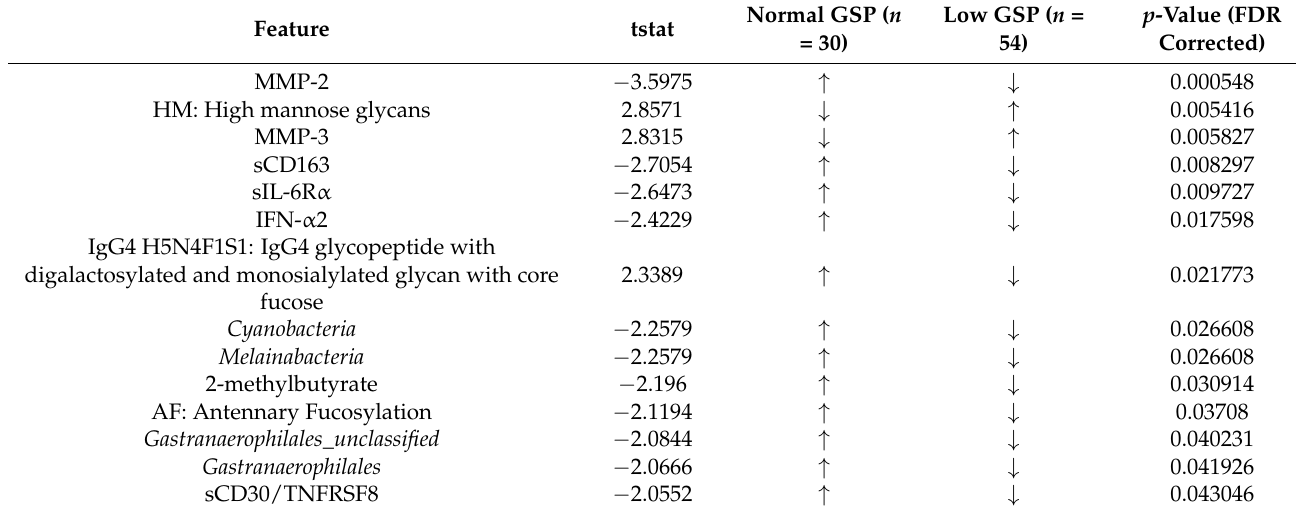
Table 3. Features which demonstrate differential responses between normal and low glycated serum protein (GSP) levels ( µ mol/L). Low GSP = 0–199; Normal GSP = 200–285; MMP-2 = Matrix metalloproteinase-2; MMP-3 = Matrix metalloproteinase-3; sCD163 = Soluble CD163; sIL-6R α = Soluble interleukin 6 receptor alpha; IFN- α 2 = Interferon alpha-2; sCD30/TNFRSF8 = Tumour necrosis factor receptor superfamily member 8; Two-tailed Student’s t- test. An FDR corrected p -value is shown in the last column. Arrows ( ↑ / ↓ ) represent features that were increased/decreased in the corresponding population.